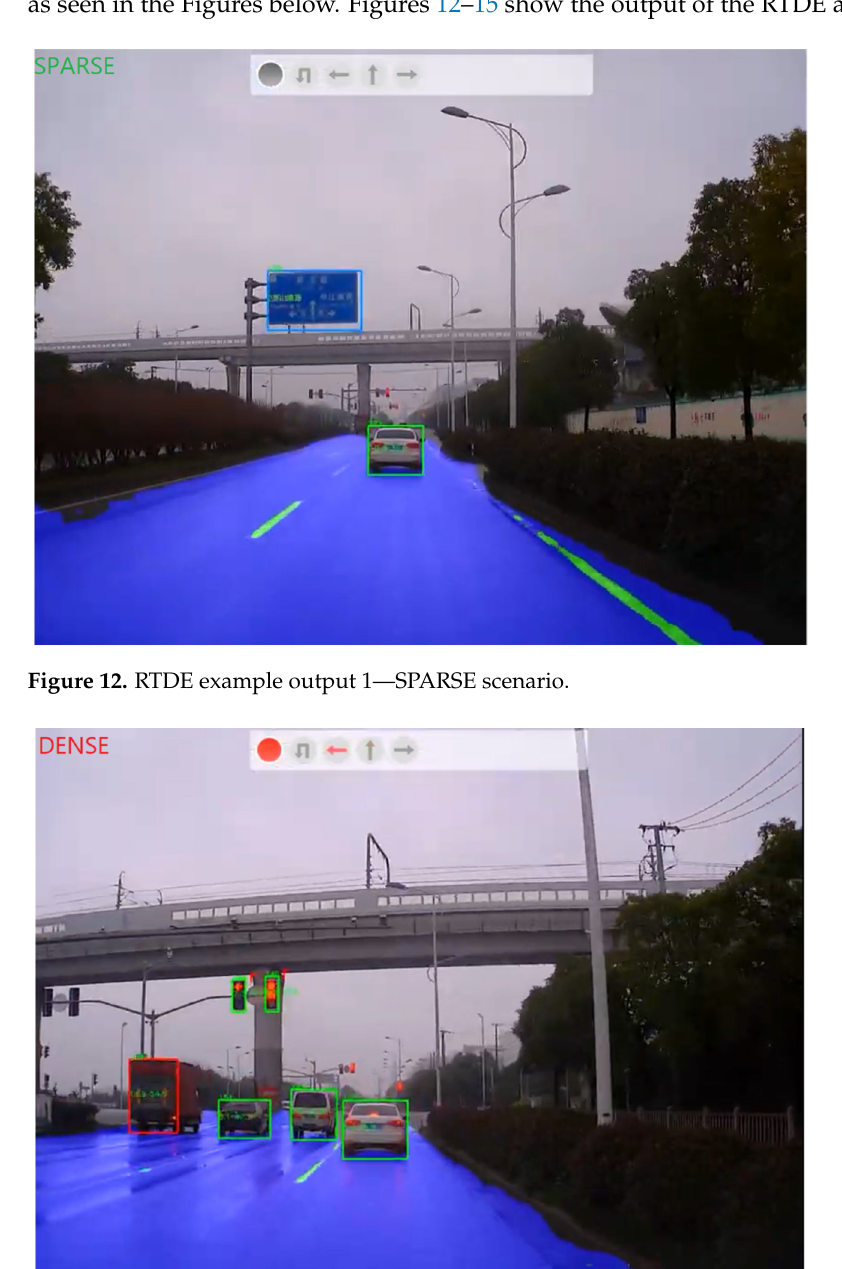
Figure 14. RTDE example output 3—DENSE scenario.